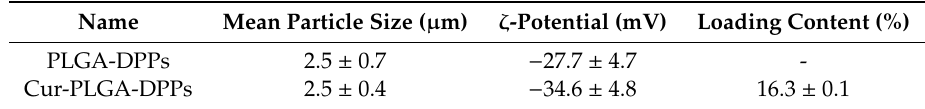
Table 1. Size, zeta potential, and drug-loading capacity of curcumin-containing poly(lactic- co -glycolic